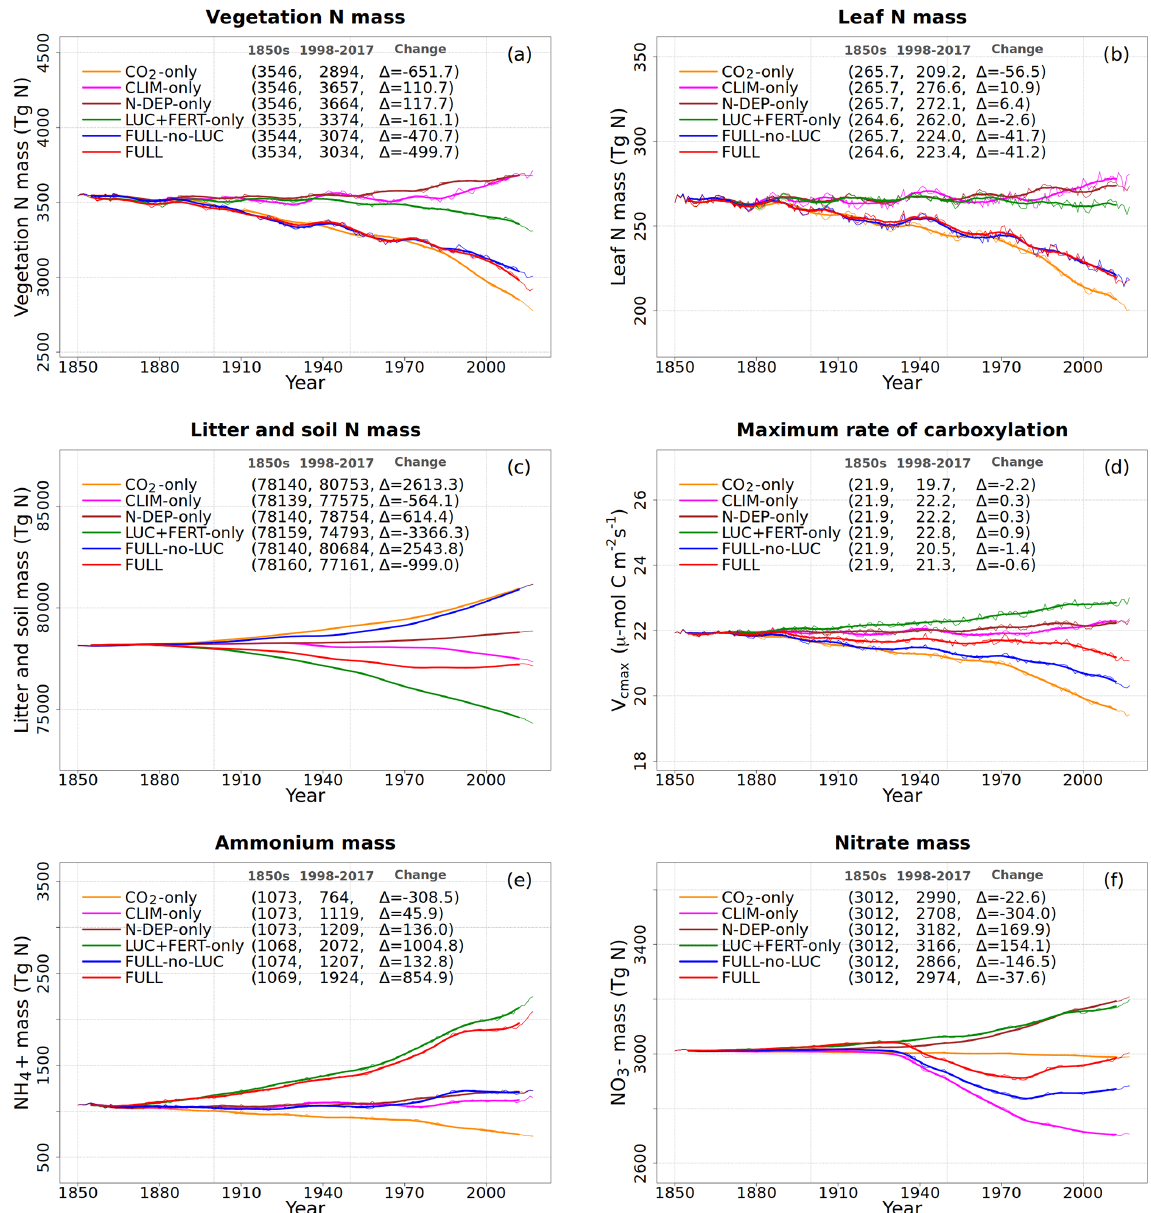
Figure 5. Global annual values of N in vegetation (a) , leaves (b) , litter and soil organic matter (c) pools, V cmax (d) , and ammonium (e) and nitrate (f) pools for the primary simulations performed. The values in the parentheses for legend entries show the average for the 1850s, the average for the 1998–2017 period, and the change between them. The thin lines show the annual values, and the thick lines show their 10-year moving